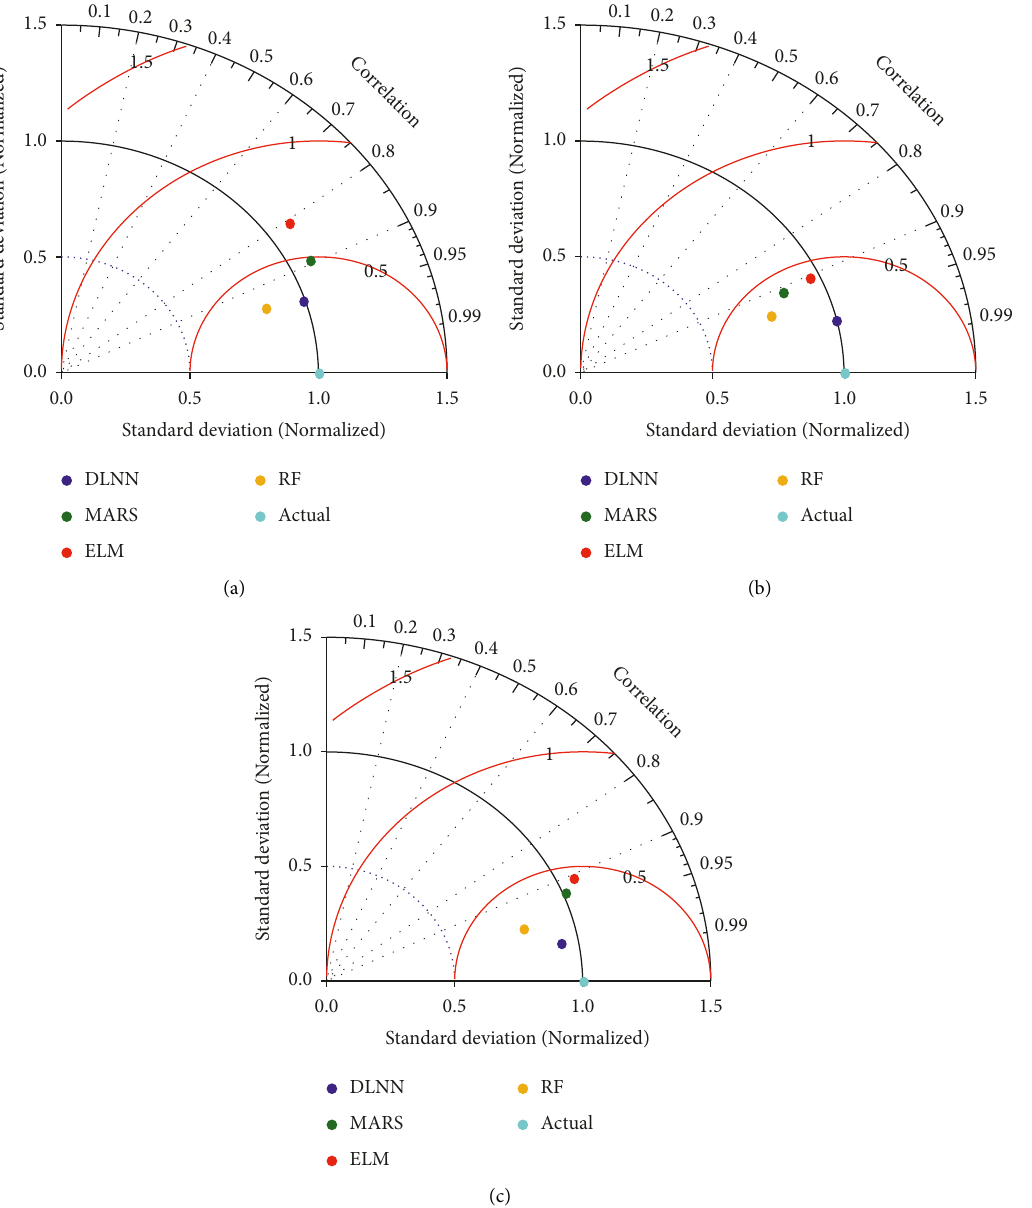
Figure 11: Taylor diagram for the developed AI model over all data division scenarios. (a) Scenario I. (b) Scenario II. (c) Scenario III.